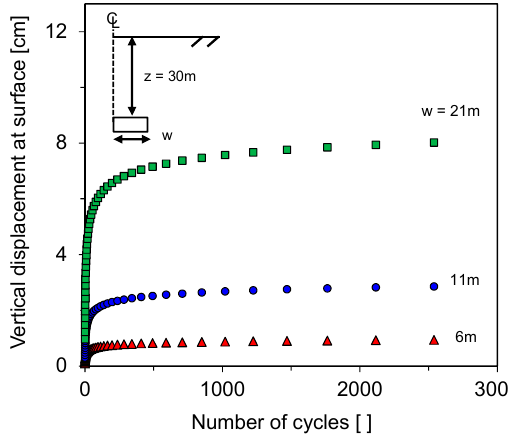
Figure 8. The effect of storage width on the displacement evolution. The case storage location z o = 30 m and cyclic stress amplitude Δ P/P avg = 10%.